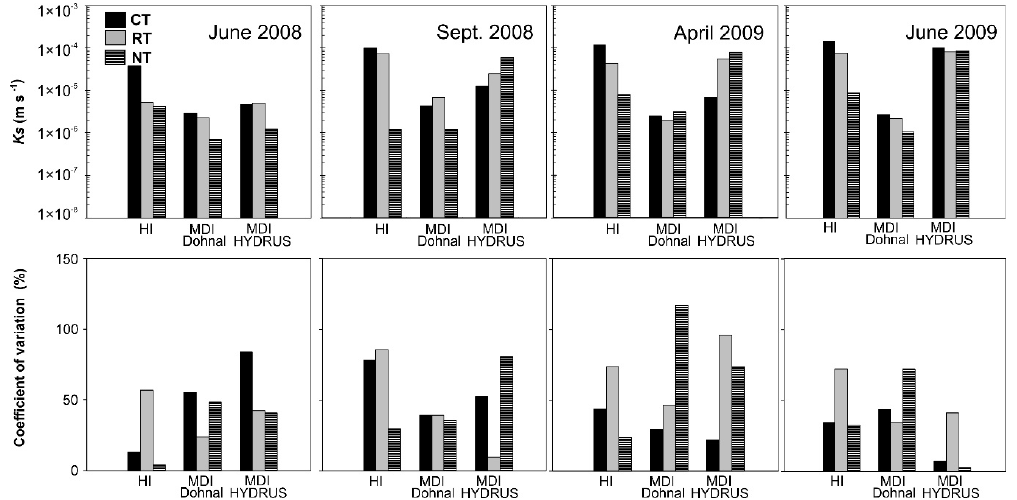
Figure 6. Comparison of Ks data determined by HI, and MDI (upper part), with corresponding variation coefficients (lower part).